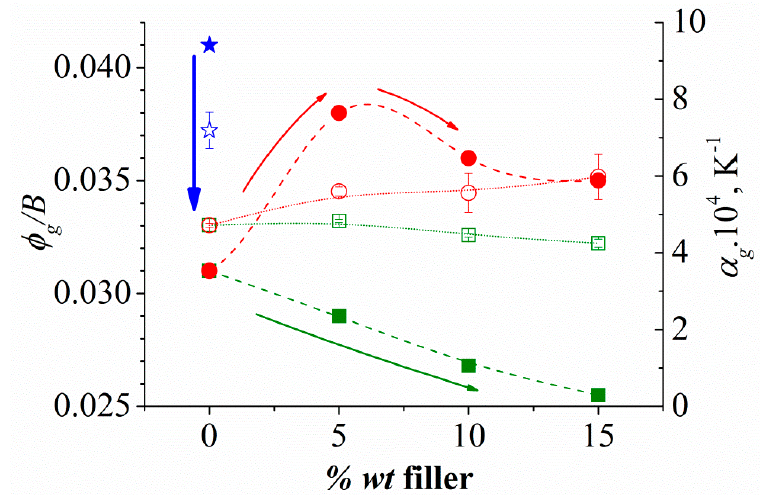
Figure 6. Filler content dependence of the relative free volume at the glass temperature, φ g / B (full symbols) and the value of the expansion coefficient of the free volume, α f (open symbols) for both KCg / x MMT (square) and KCg / x CHW (cicle) nanocomposites ( x = 0, 5, 10 and 15). Stars correspond to the sample without glycerol